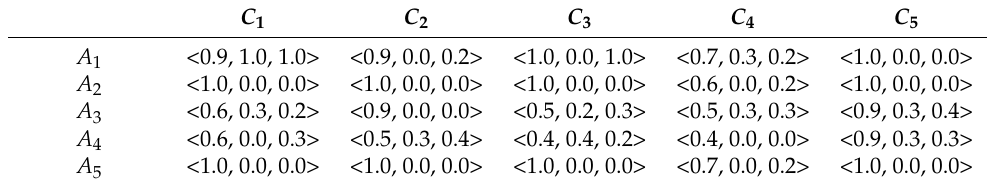
Table 14. The ratings obtained from the third of three